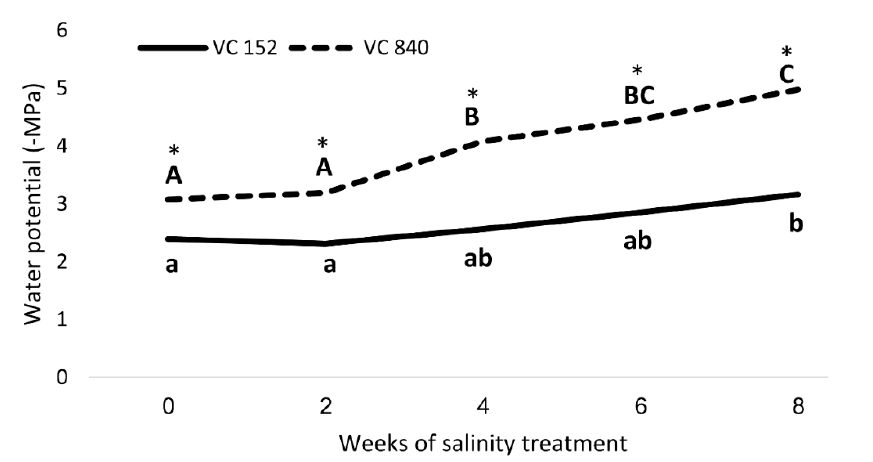
Figure 9. Stem water potential in ‘Hass’ avocado trees grafted onto either VC152 or VC840 rootstocks along eight weeks of salinity treatment. * represents a significant difference ( p ≤ 0.05) between the rootstocks. Different letters represent significant differences between measurement dates in a specific rootstock.